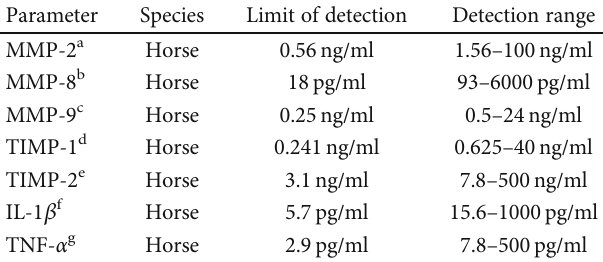
Table 2: Species, limits of detection, and detection ranges of ELISA kits used for quanti fi cation of matrix-metalloproteinase (MMP), tissue inhibitors of metalloproteinase (TIMP), interleukin (IL)-1 β , and tumor necrosis factor-alpha (TNF- α ) concentration in equine plasma and peritoneal fl uid. Details on manufacturers are given in the